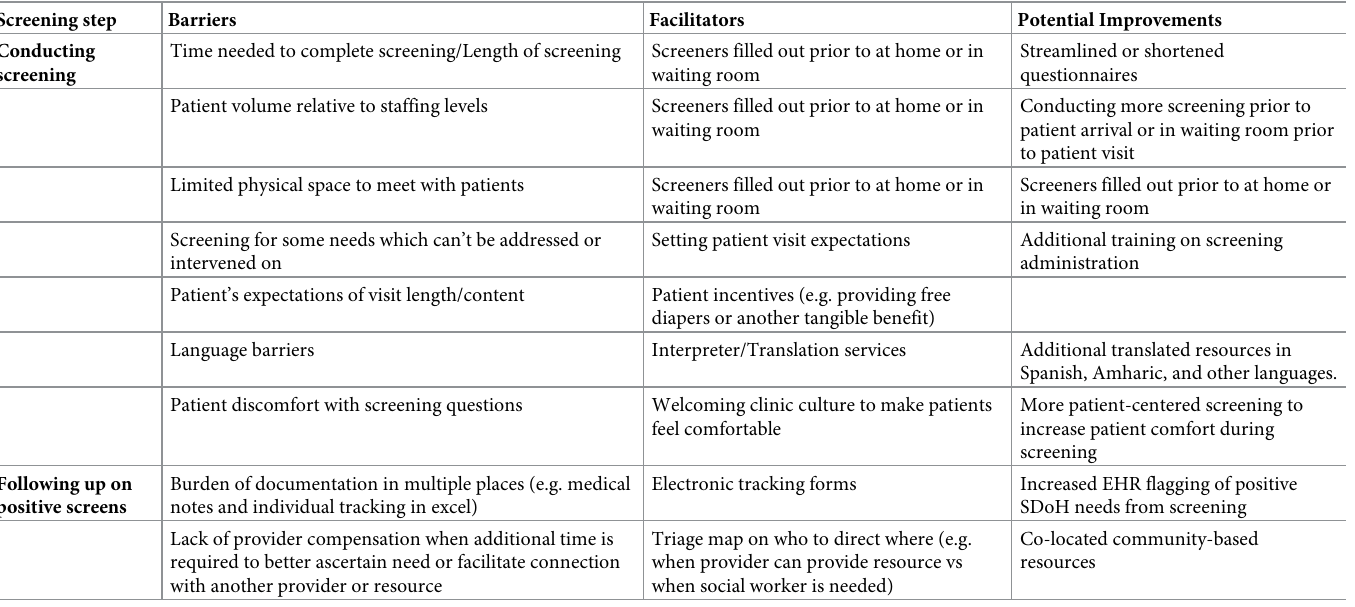
Table 3. Summary of social risk factor screening barriers, facilitators, and potential improvement